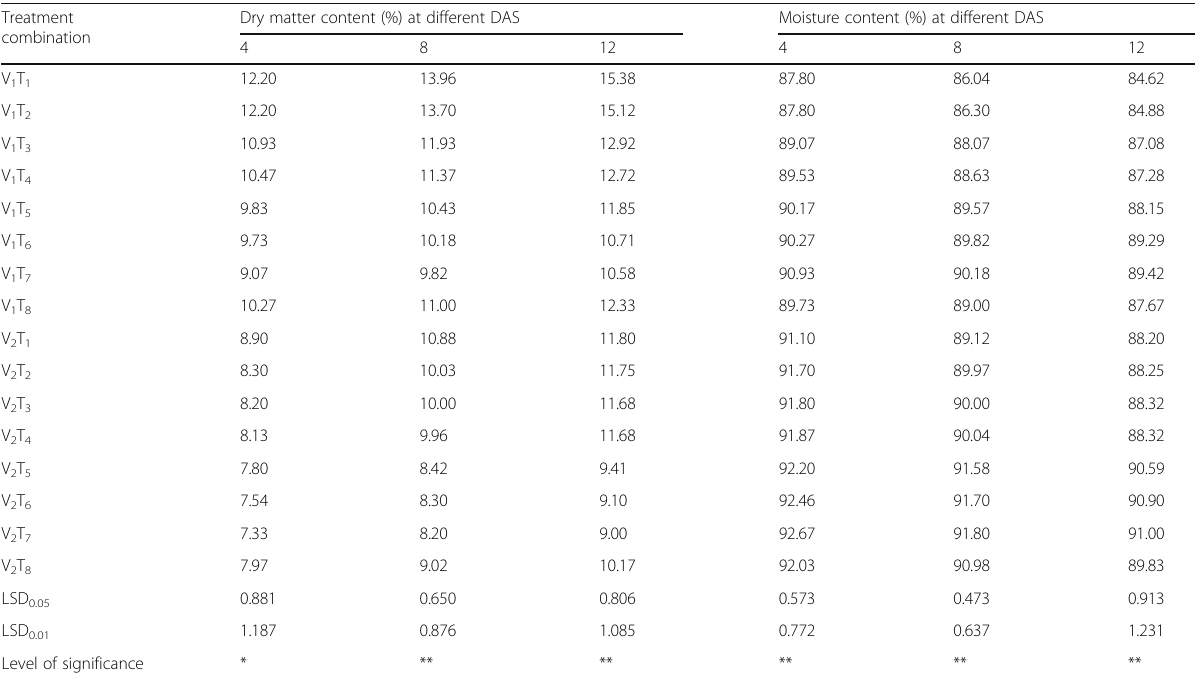
Table 6 Combined effect of varieties and postharvest treatments on moisture content and dry matter content of tomato during storage and ripening Treatment Dry matter content (%) at different DAS Moisture content (%) at different DAS combination